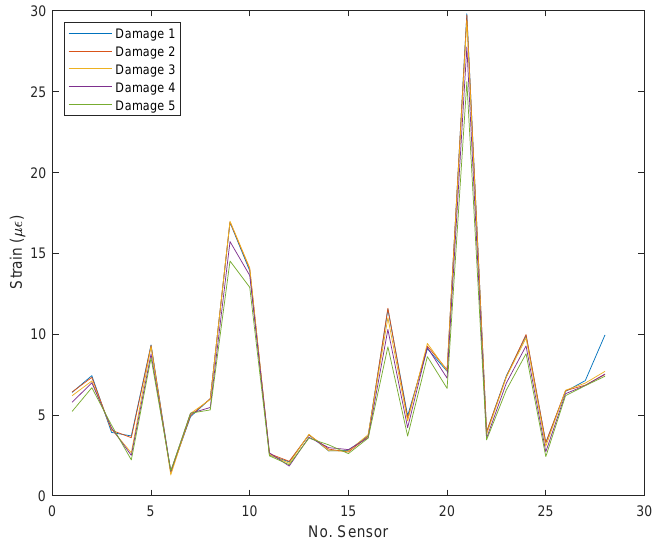
Figure 9. Average strain versus sensor number (FBG number) for an excitation frequency of 20 Hz and for the five levels of damage